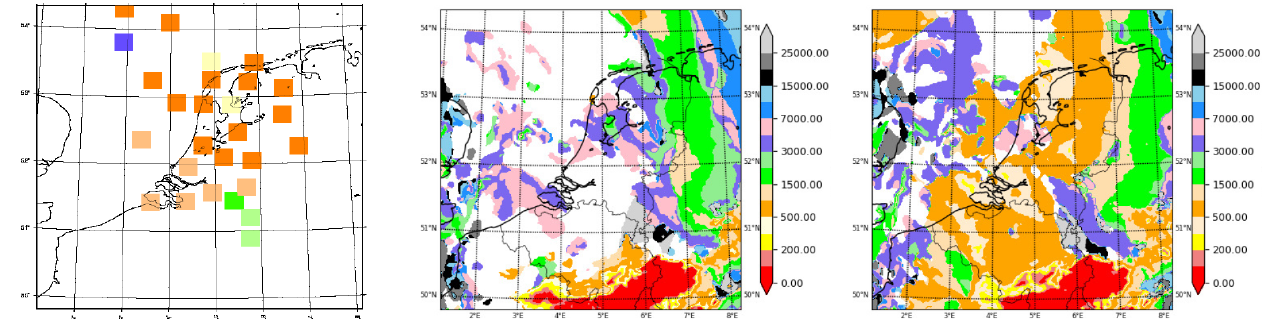
Figure 19. Cloud base height in feet (1ft is 0.3048m) on 19 December 2018 at 09:00UTC as measured at discrete observation site locations in the Netherlands and part of the North Sea (left panel), forecasted by cy40REF (middle panel) and cy40NEW (right panel). Note that white in the left panel means that there is no observation available, whereas white spots in the middle and right panels mean no cloud base height was detected because all model levels have a cloud fraction < 5 . 8